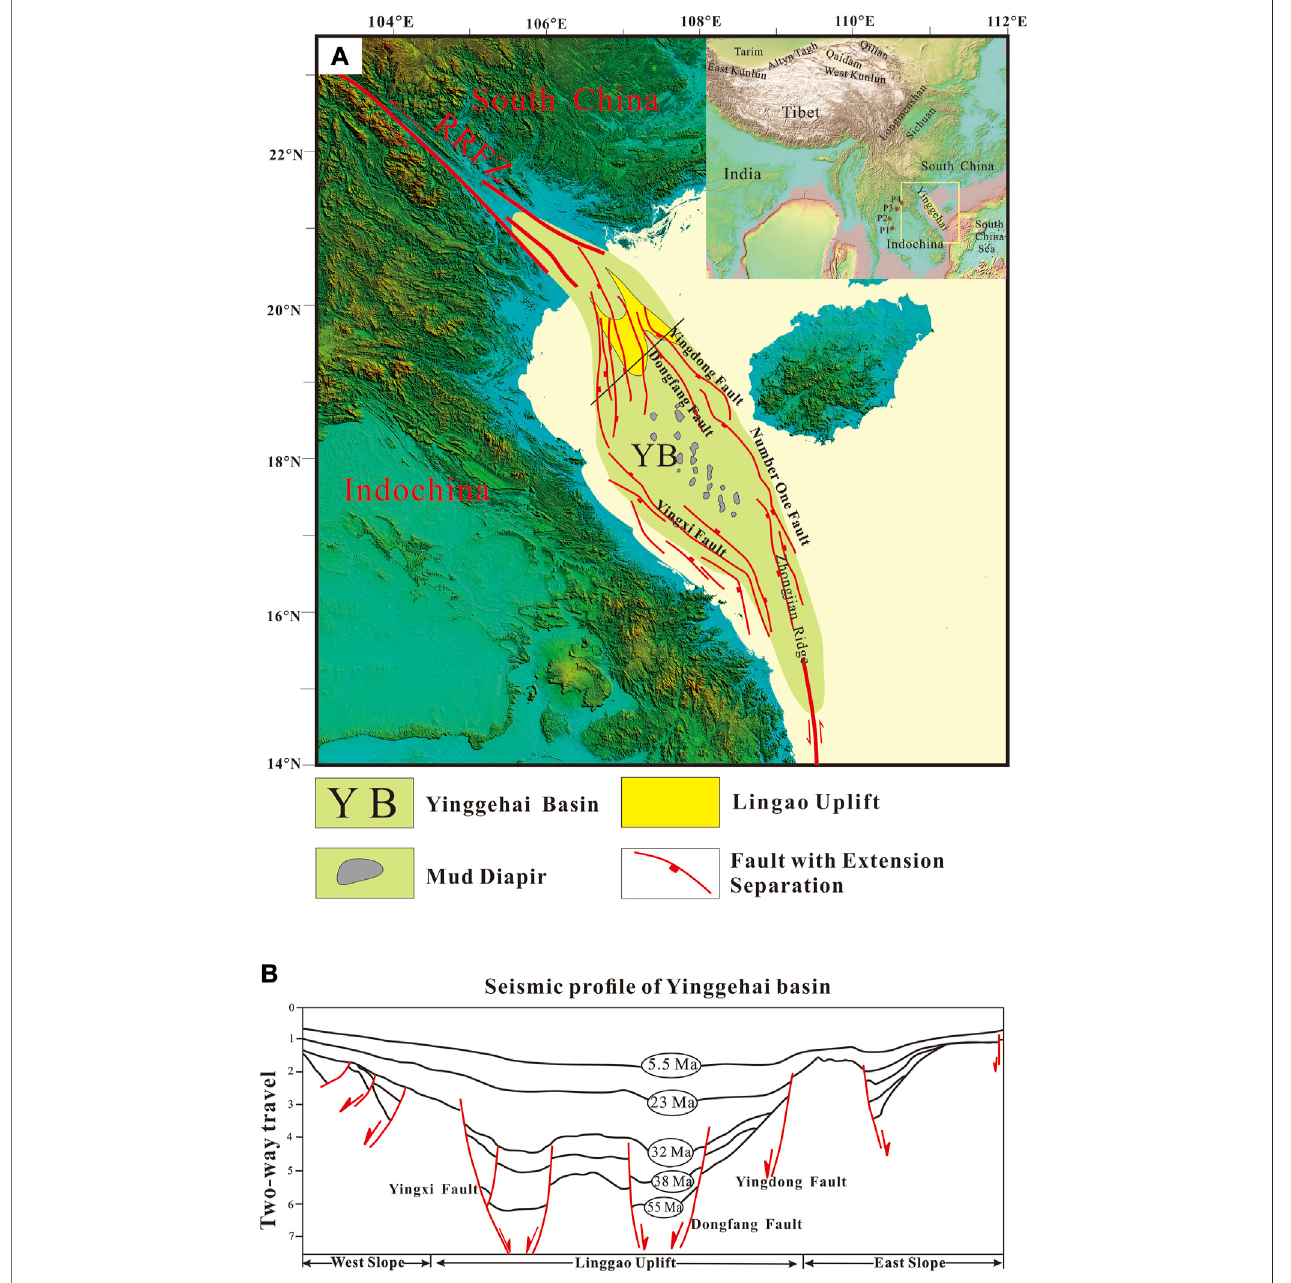
FIGURE 1 | (A) Tectonic map showing the tectonic units and faults in the Yinggehai Basin. Rectangular frame in the top right corner large-scale map is our study area. The four red dots represent four rotational poles (P1, P2, P3, and P4); (B) seismic pro fi le of the Yinggehai Basin (modi fi ed after Lei et al., 2015).